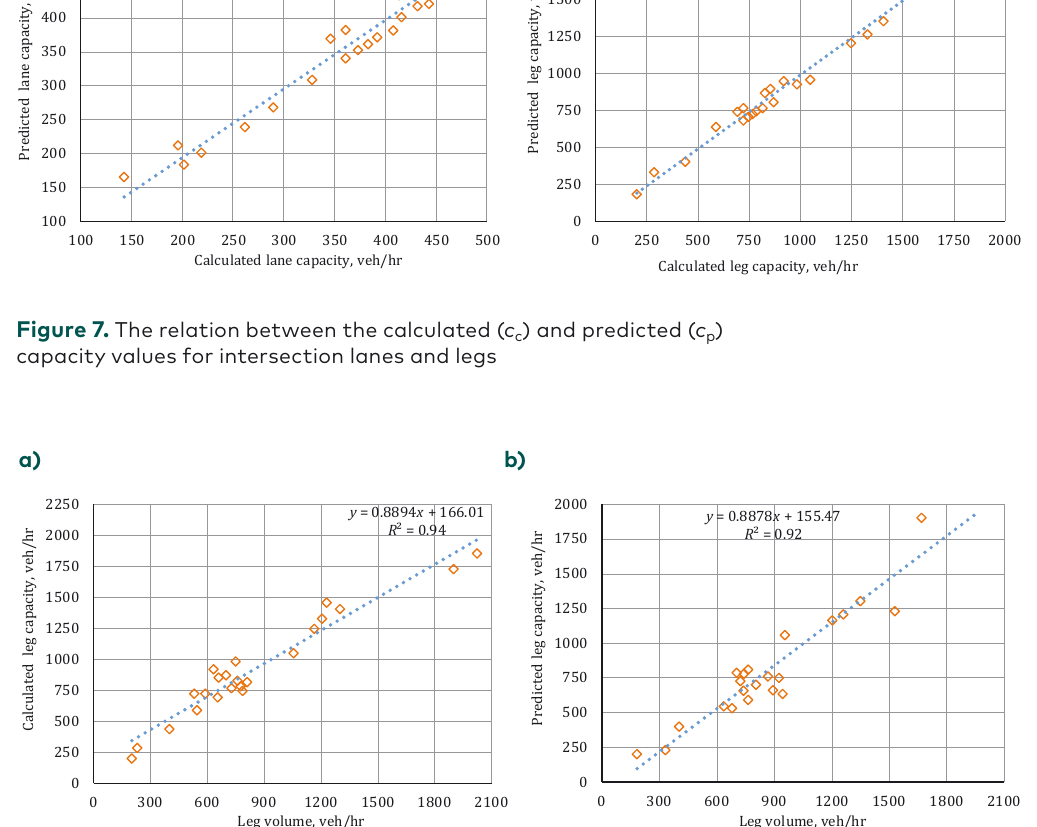
Figure 8. Calculated-predicted capacities and volumes for signalized intersection legs